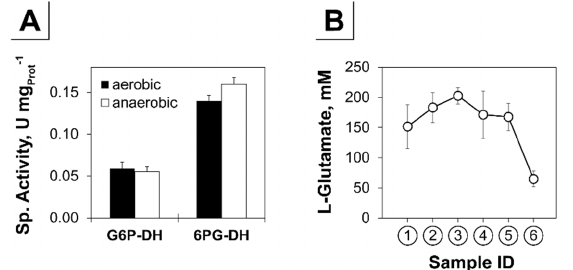
Figure 4 . ( A ) Specific activities of the glucose-6P dehydrogenase (G6P-DH) and 6P-gluconate dehydrogenase (6PG-DH) in U per mg total protein. ( B ) Intracellular L -glutamate analysis in samples taken during the triple-phase process [aerobic ( ① , ② ), microaerobic ( ③ , ④ , ⑤ ), anaerobic conditions ( ⑥ ); Figure 1A]. Error bars represent SD of three ( A ) or four ( B ) independent experiments.